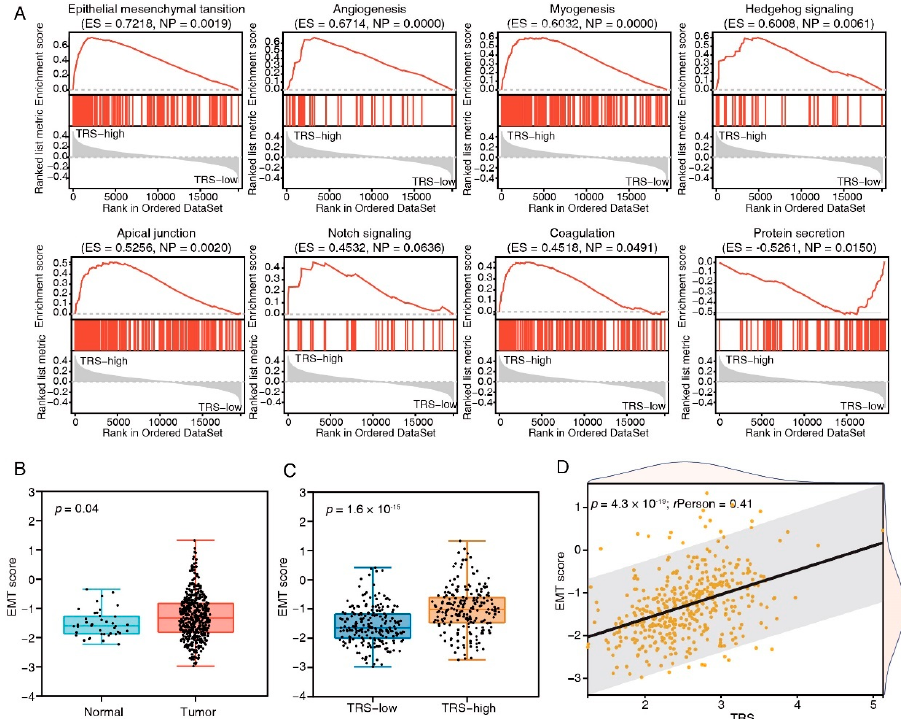
Figure 5. Biological pathways of TFEB score subtypes. ( A ) GSEA enrichment plots showing the 8 most enriched cancer hallmark pathways (p < 0.05). ( B ) The comparison of EMT scores in tumor and normal tissues in the TCGA-COAD cohort. ( C ) The comparison of EMT scores in high- and low-risk groups in the TCGA-COAD cohort. ( D ) The correlation analysis between EMT scores and risk scores.